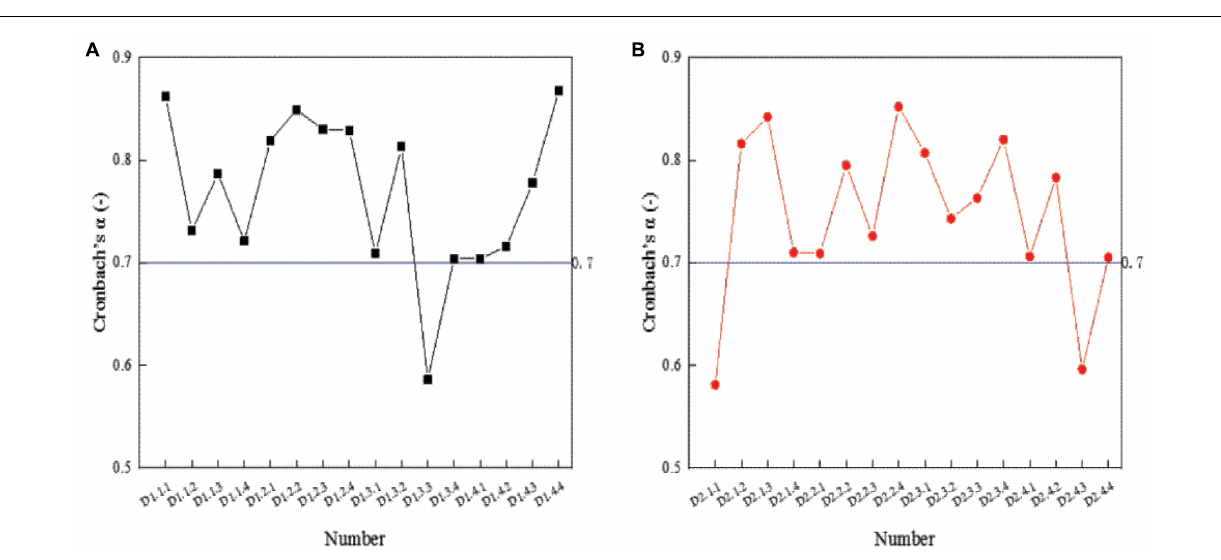
corresponding from “not consistent” to “totally